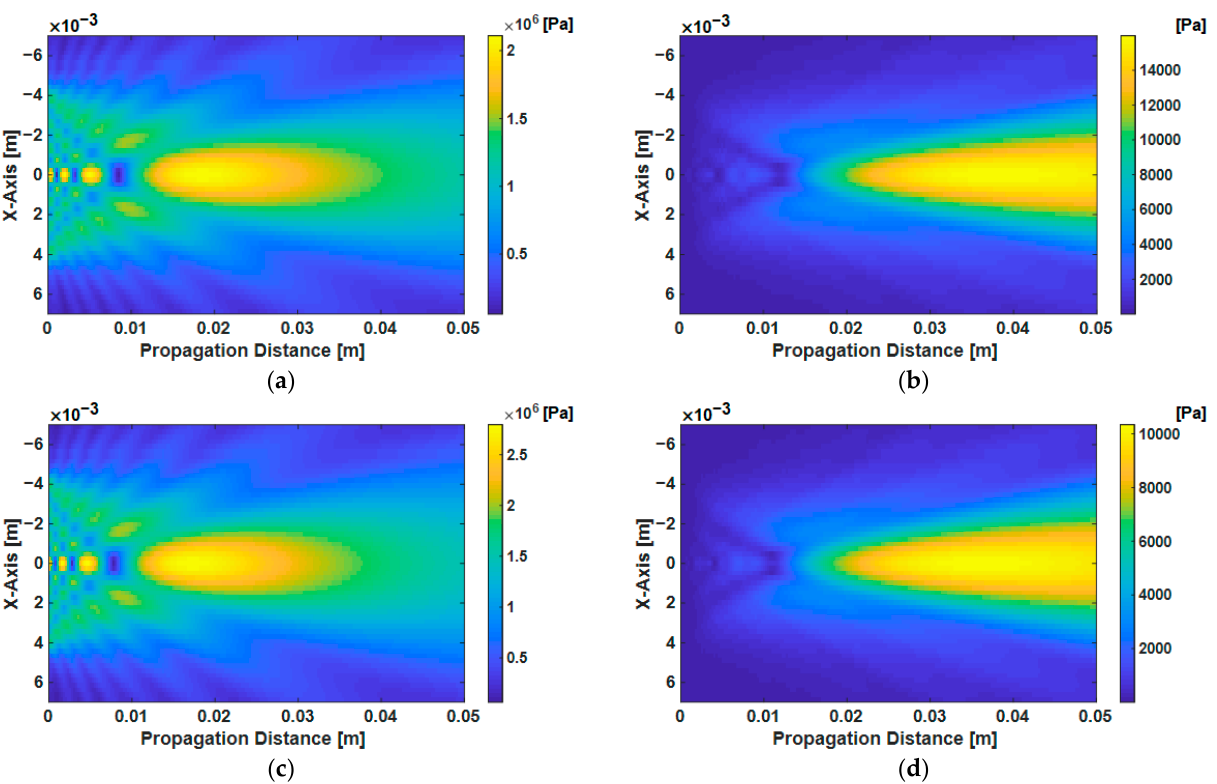
Figure 3. Numerical calculation results of the ultrasonic pressure field of fundamental wave p 1 ( n ) calculated using Equation (2), and second harmonic wave p ( n ) using Equation (4) with = 0.1 m/s at 5 MHz driving frequency: ( a ) fundamental wave and ( b ) second harmonic wave in fused silica; ( c ) fundamental wave and ( d ) second harmonic wave in the Al6061-T6.